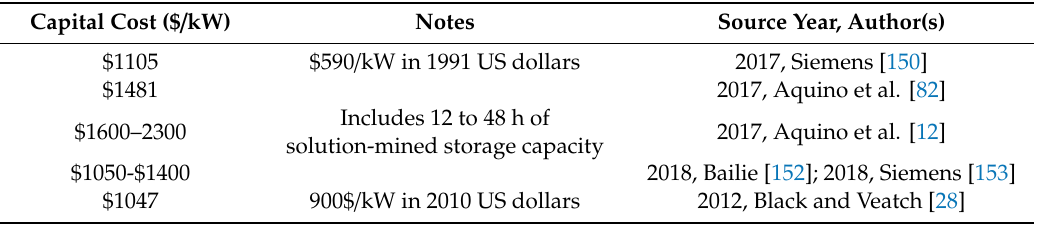
Table 31. Capital cost estimates—compressed air energy storage (CAES)